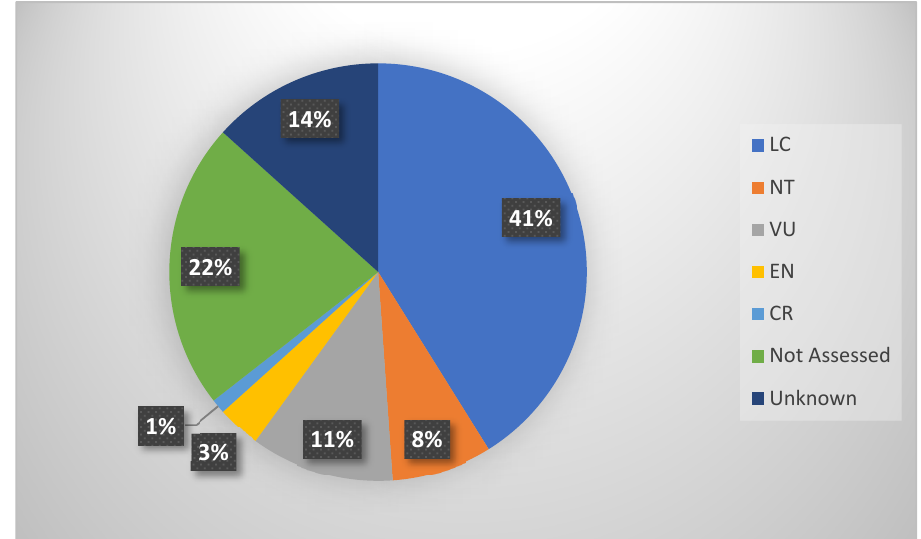
Forests 2021 , 12 , x FOR PEER REVIEW